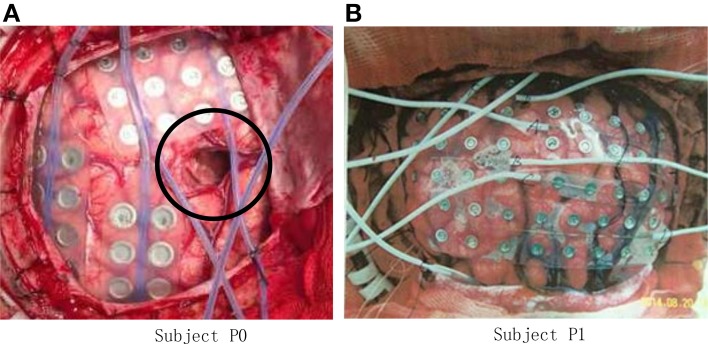
Photo of ECoG grids placed on the brain cortex surface. (A) Grid photo of Subject P0, the black circle indicates the resection cortex of brain tumor; (B) Grid photo of Subject P1.